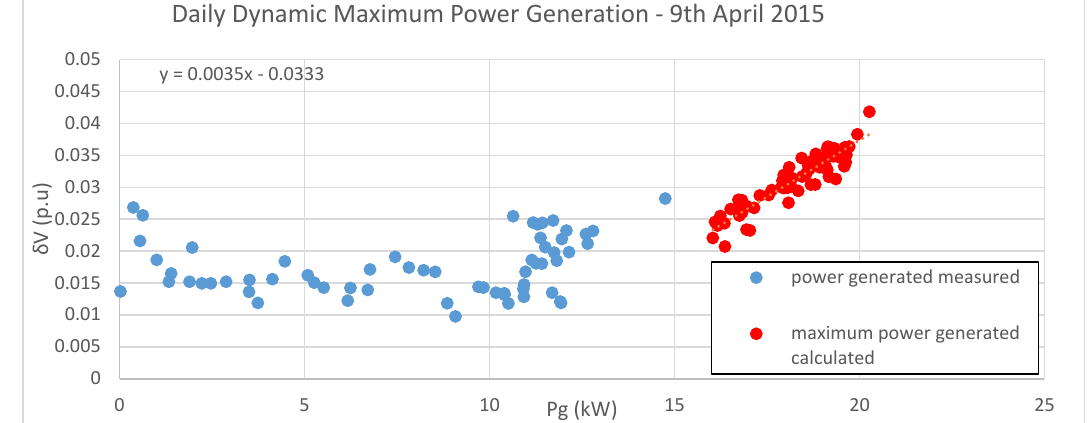
Figure 4. Voltage variation x generated power and the linear dependency in relation to the maximum amount of power calculated by (5)—April 9th, 2015.